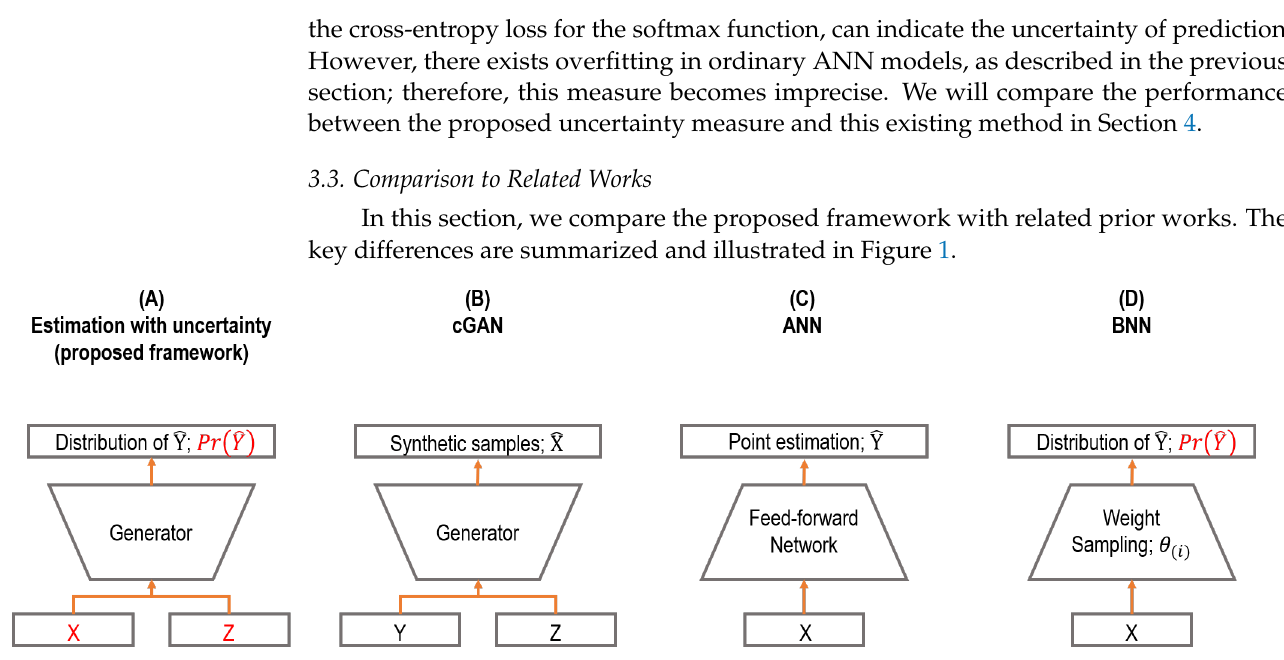
Figure 1. Comparison to related works. ( A ) cGAN as a prediction model (the proposed framework); ( B ) ordinary cGAN for sample generation; ( C ) artificial neural networks for prediction; ( D ) Bayesian neural